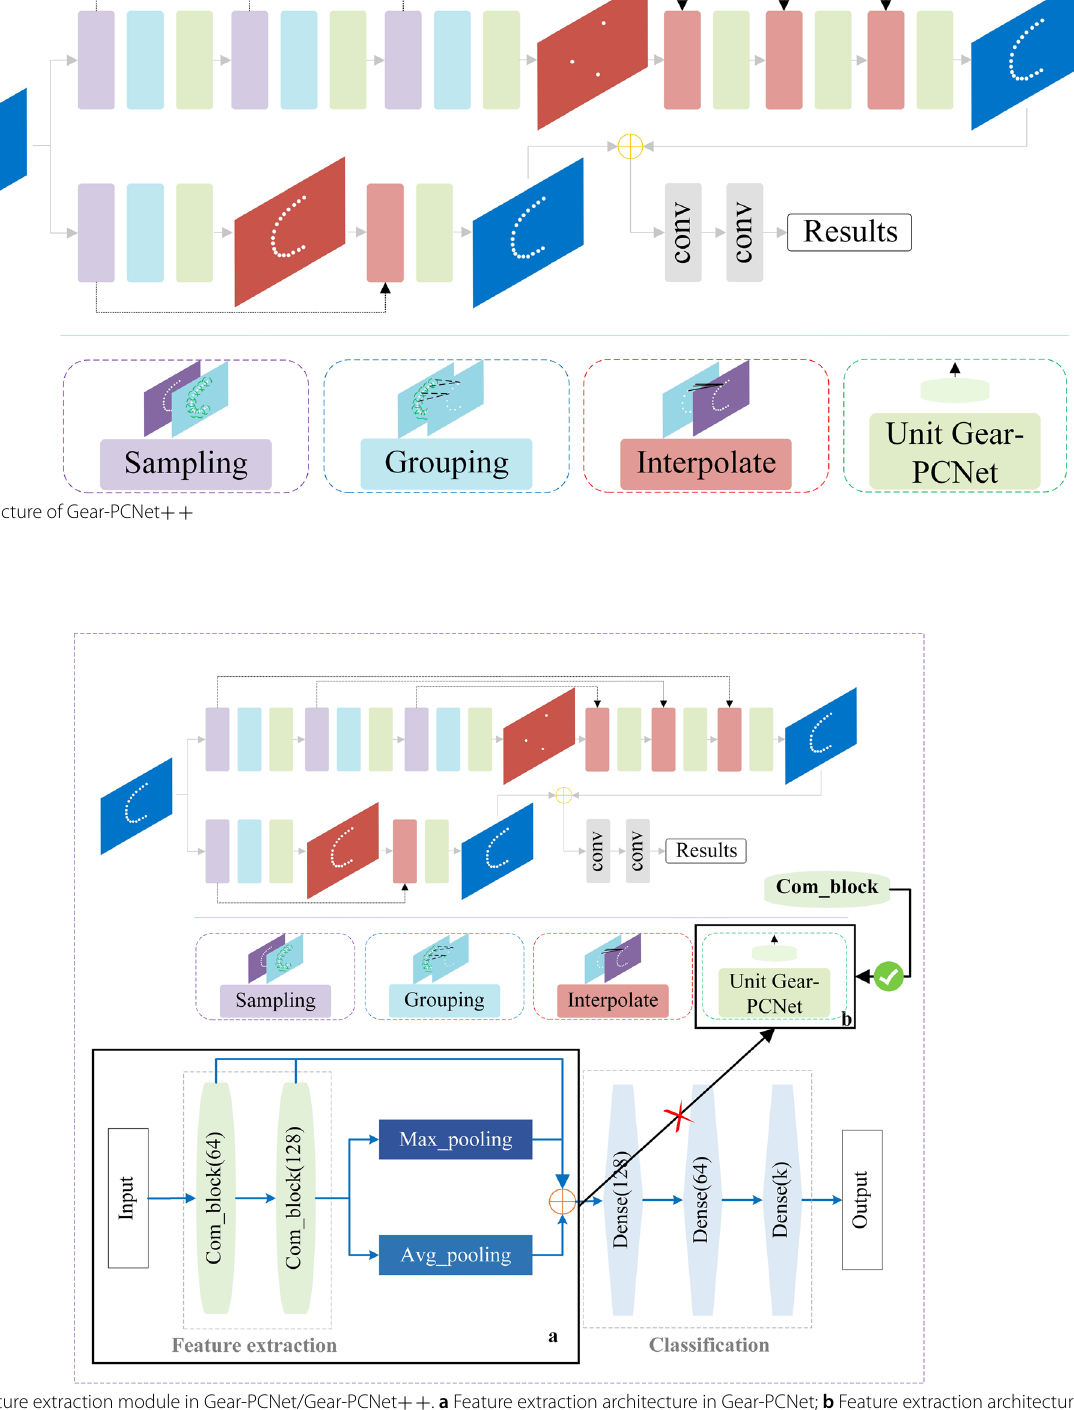
. a Feature extraction architecture in Gear-PCNet; b Feature extraction architecture + +